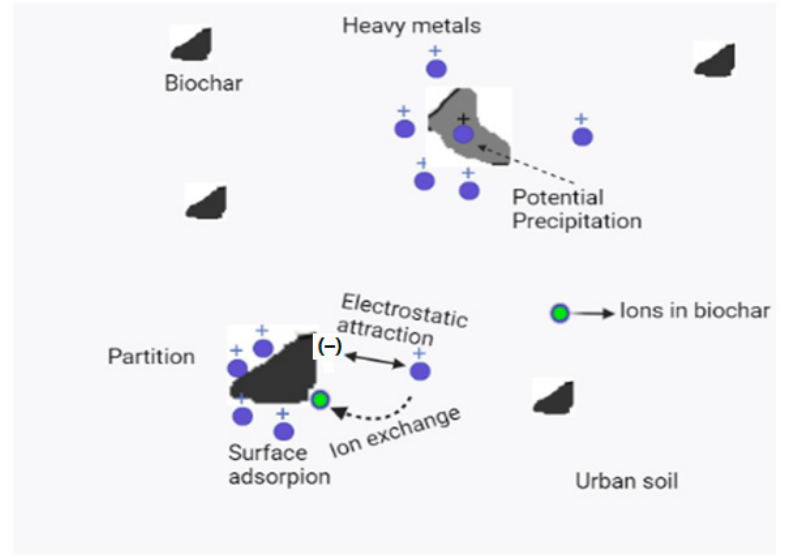
Figure 4. Mechanistic pathways for Pb and Cd immobilization using biochar. Figure 3. Mechanistic pathways for Pb and Cd immobilization using